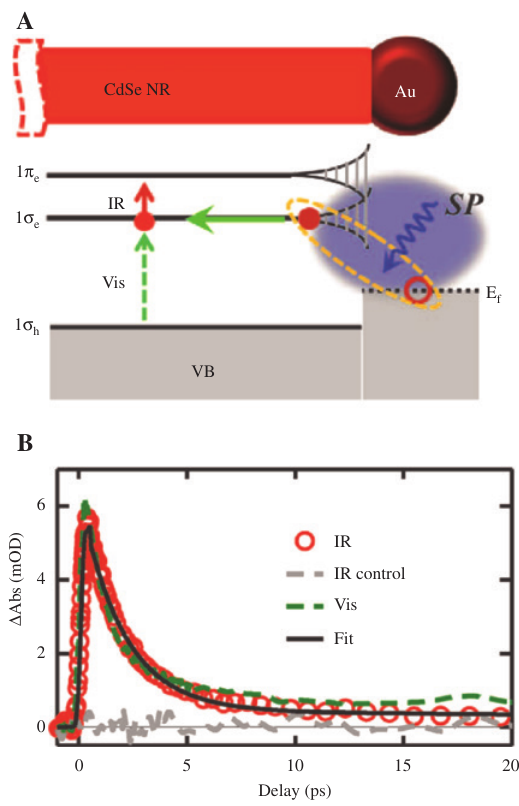
Figure 10: Transient absorption studies of plasmon-induced interfacial charge